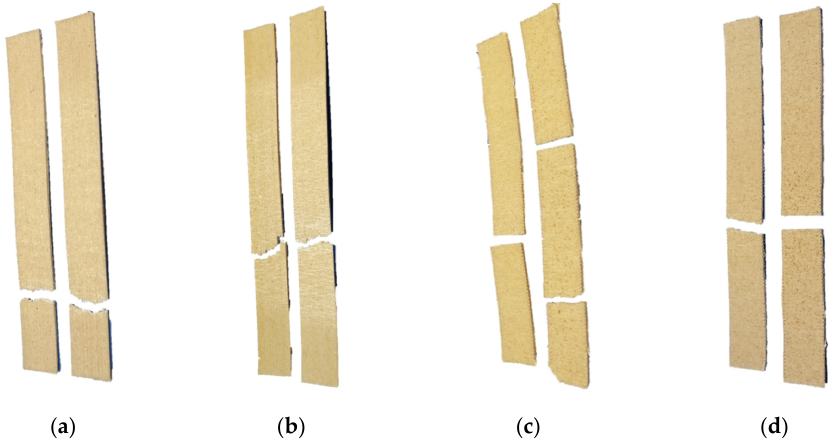
Figure 7. Tensile test fractured specimens. ( a ) rPP/RH 5 wt.% at 0°: Angled gage bottom (AGB) failure mode; ( b ) rPP/RH 10 wt.% at 0°: Angled gage middle (AGM) failure mode; ( c ) rPP/RH 5 wt.% at 90°: Lateral gage middle (LGM) failure mode; and (d) rPP/RH 10 wt.% at 90°: Lateral gage middle (LGM) failure mode.